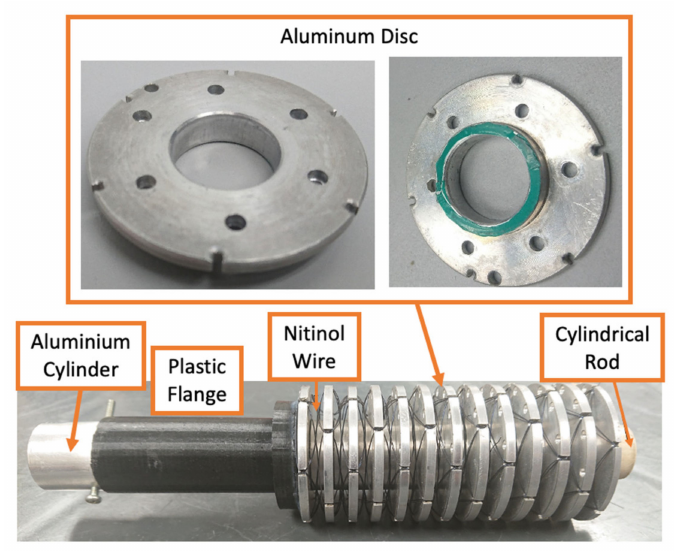
Figure 2. Nitinol wire